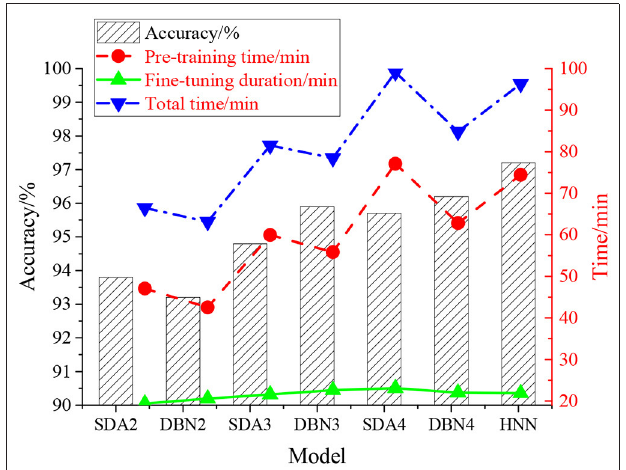
FIGURE 8 | Comparison of different input